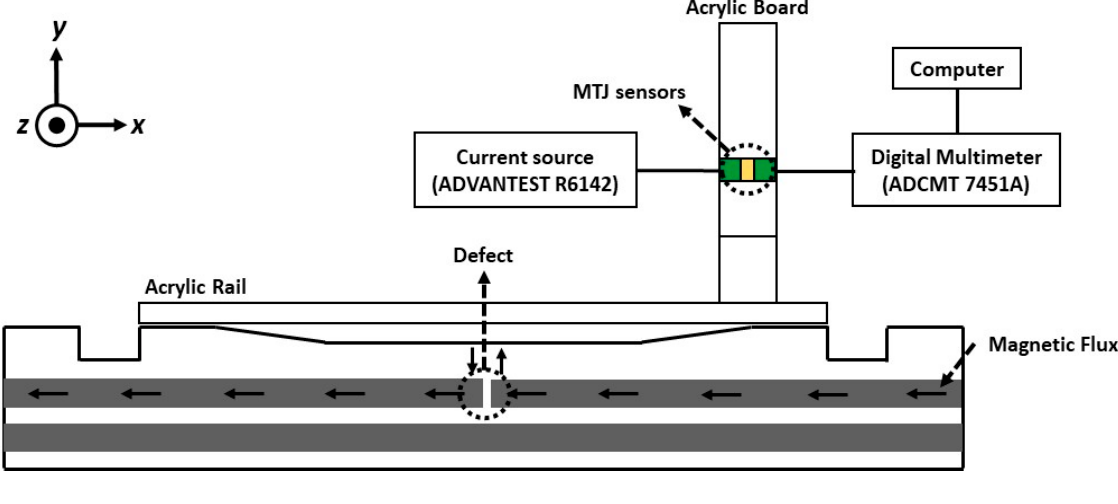
Figure 1. Experiment setup for the magnetic shield room measurement.